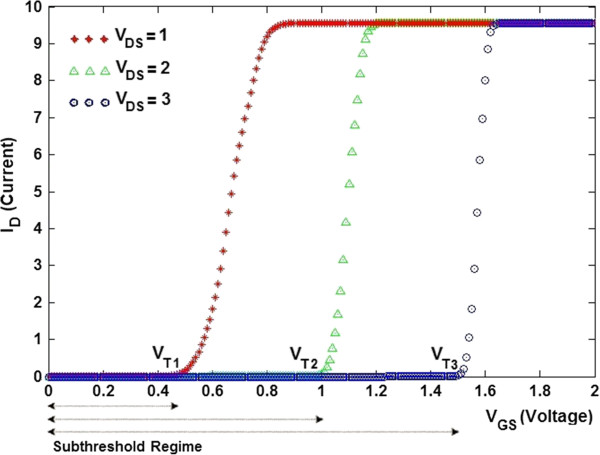
Subthreshold regime of TGN SB FET at different values of VDS (V) for L = 25 nm.